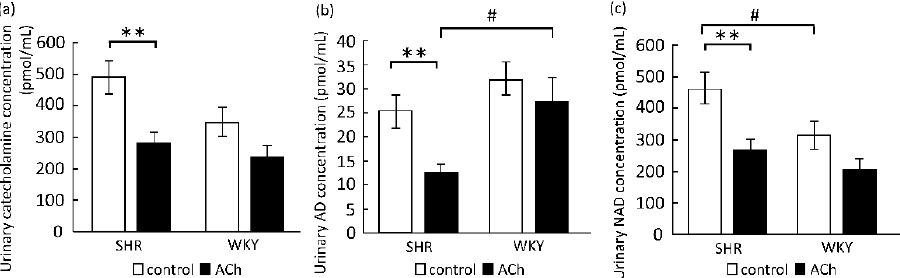
Figure 3. Excretion of catecholamine ( a ), AD ( b ), and NAD ( c ) in urine samples collected from SHR and WKY rats 6–12 h after oral administration of ACh (10 − 3 mol/kg b.w.) or pure water (control). □ : Control (n = 6). ■ : ACh 10 − 3 mol/kg b.w. (n = 6). The catecholamine concentration was calculated as sum of the concentrations of AD and NAD. Each data point and error bar represent the mean ± S.E. ** p < 0.01, versus the control group, # p < 0.05, versus WKY rats, as evaluated by a Student’s t -test. AD, adrenaline; NAD, noradrenaline; ACh, acetylcholine; SHR, spontaneously hypertensive rat; WKY, Wistar–Kyoto; b.w., body weight.